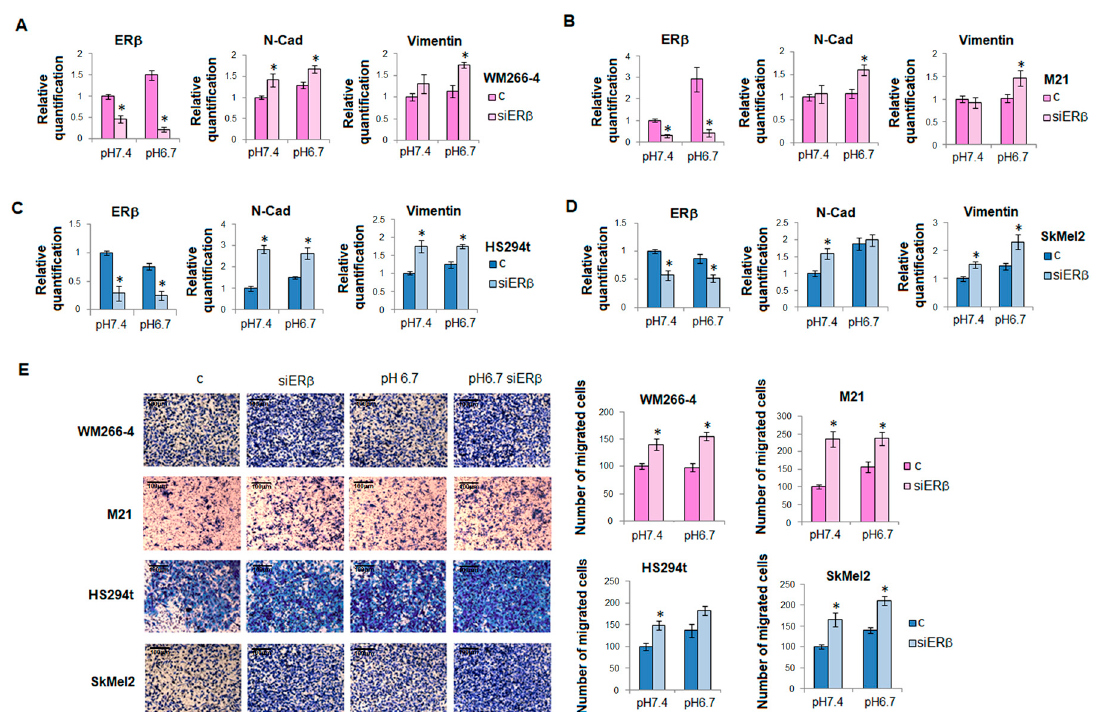
Figure 4. EMT in ER β silenced melanoma cell lines. mRNA level of ER β , N-cadherin, and vimentin in WM266-4 ( A ), M21 ( B ) female melanoma cells and in HS294t ( C ) and SKMEL2 ( D ) male melanoma cells. ( E ) Invasive ability of male and female melanoma cells silenced for ER β , grown in standard pH or acidic pH medium. Invasiveness was performed using Matrigel-coated filters and it was measured as a percentage of the control. Data are expressed as means ± SEM of three independent experiments. * p <